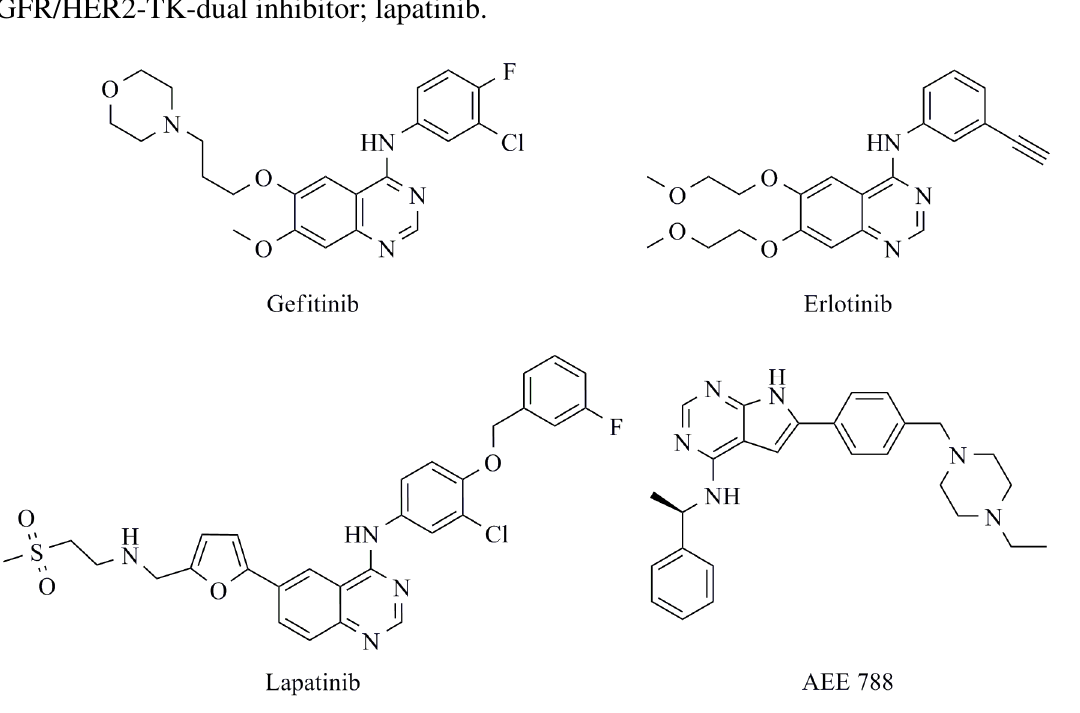
Figure 1. EGFR-TK-selective inhibitors; gefitinib, erlotinib and AEE788 and EGFR/HER2-TK-dual inhibitor; lapatinib.